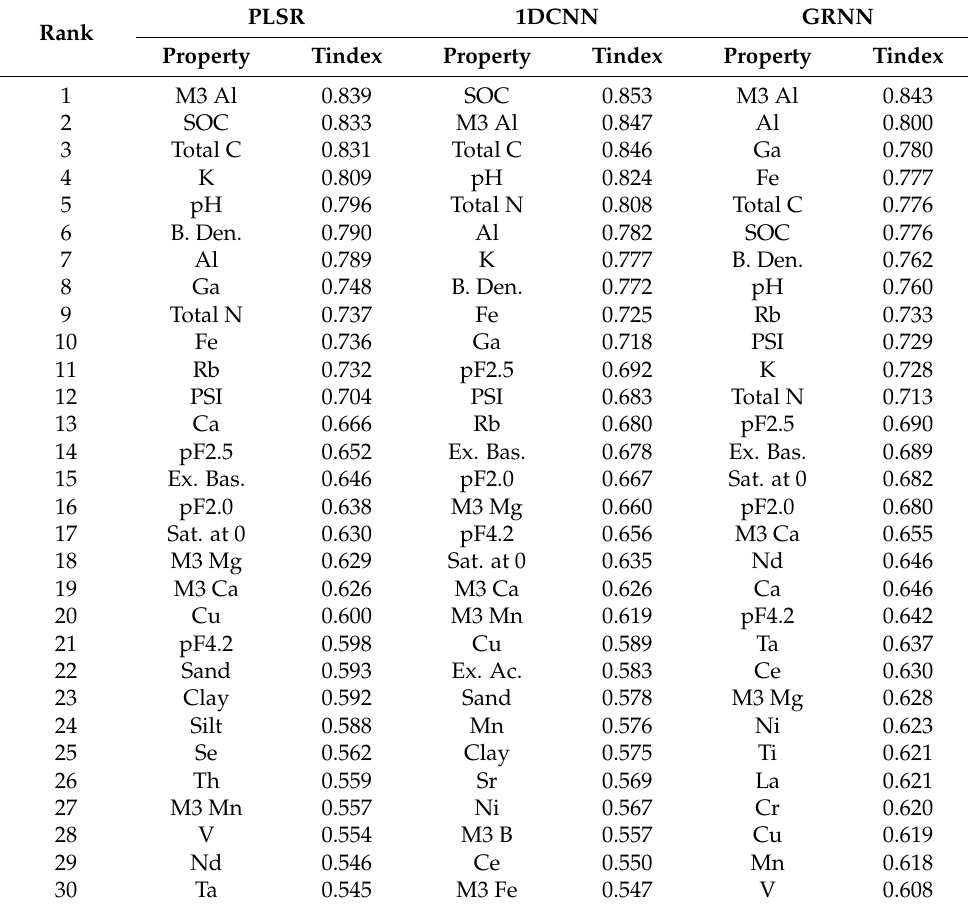
Table 6. Hierarchical summary of relative predictive position of soil